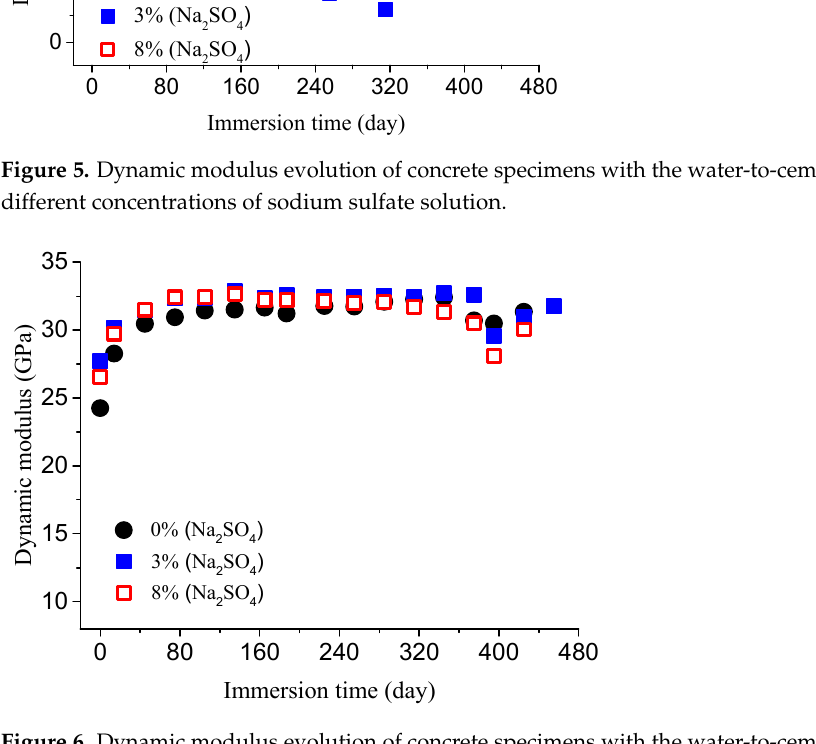
Figure 6. Dynamic modulus evolution of concrete specimens with the water-to-cement ratio of 0.7 in different concentrations of sodium sulfate.